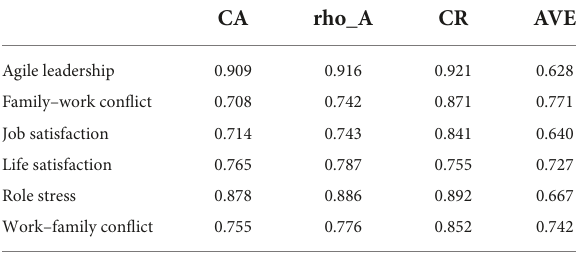
TABLE 3 Internal consistency